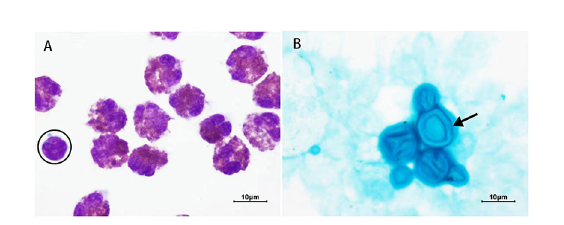
FIGURE1 Results of cerebrospinal fluid (CSF) staining. (A) Wright-Giemsa staining (1,000 X). All cells are eosinophils except the one surrounded by a black circle, which is a lymphocyte. (B) Alcian blue staining (1,000 X). Black arrow = Cryptococcus with an intact capsule. The capsule of Cryptococcus is dark blue and the thallus is light